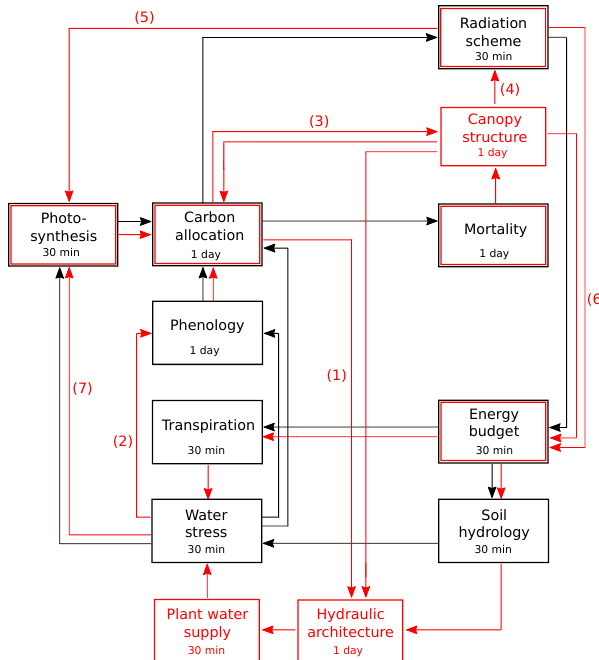
Figure 1. Schematic overview of the changes in ORCHIDEE-CAN. For the trunk the most important processes and connections are indi- cated in black, while the processes and connections that were added or changed in ORCHIDEE-CAN are indicated in red. Numbered arrows are discussed in Sect.